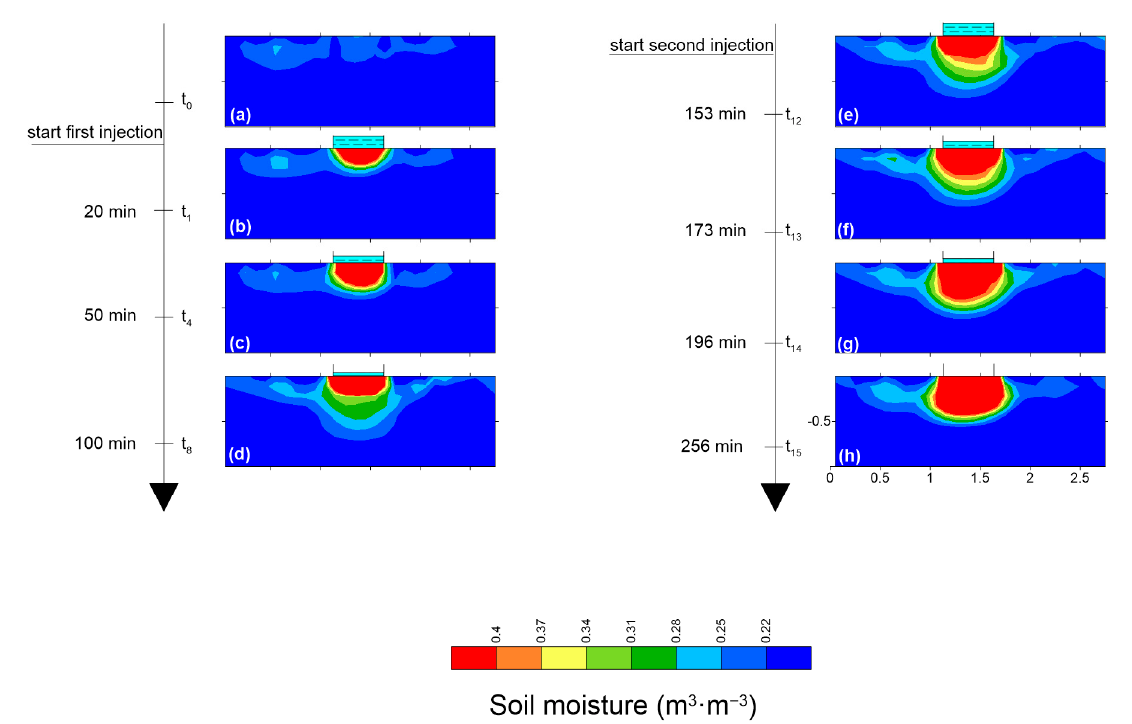
Figure 3. ERT-derived water content at different time points: ( a ) before the starting of the first injec- tion; ( b ) 20 min; ( c ) 50 min; ( d ) 100 min after the first injection; ( e ) 25 min; ( f ) 45 min; ( g ) 68 min; ( h ) 128 min after the second injection.